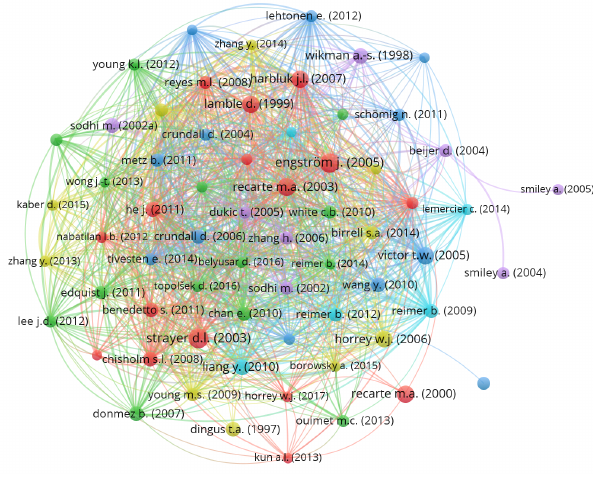
Figure 5. Bibliographic coupling.